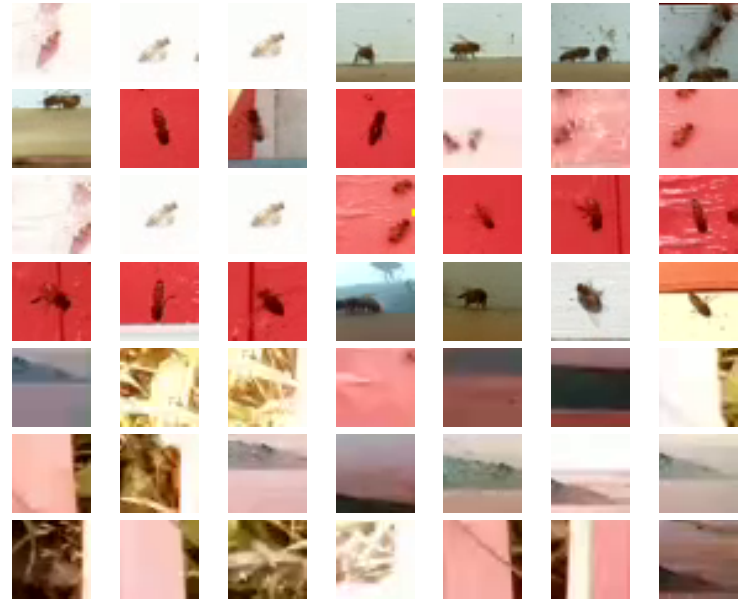
Figure 6. A sample of images from BEE1. The first four rows include images classified as BEE. The last three rows consist of images classified as